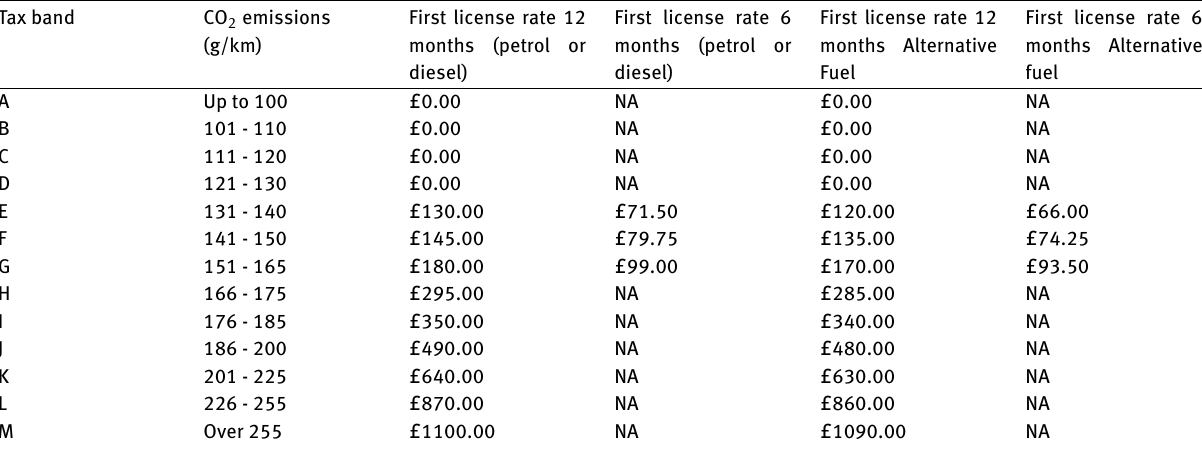
Table 1: United Kingdom car tax rates 2015/2016 (from carfueldata.dft.gov.uk, 2015a ). Tax